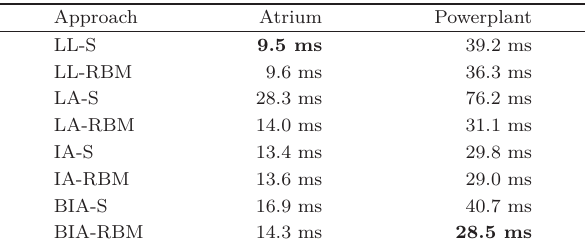
Table 3 Merging time for four input deep images using iterated pairwise merging Approach